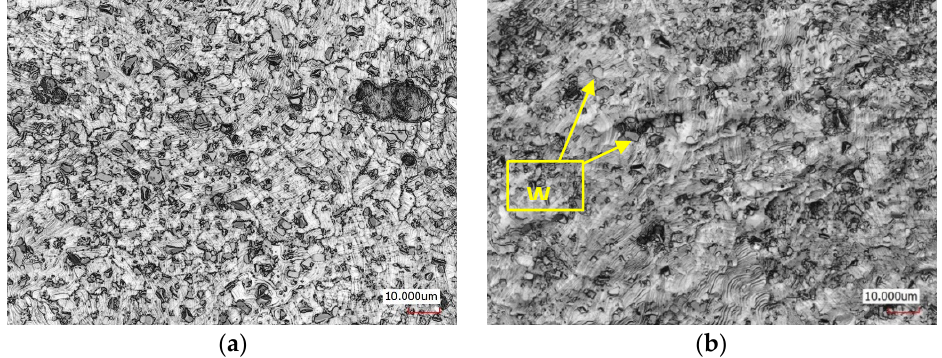
Figure 6. Surface topography of ( a ) cutting insert WC–Co, ( b ) insert with deposited W-B film. The average value of profile roughness height ( R a , R q ) and maximum height R z of the peak are